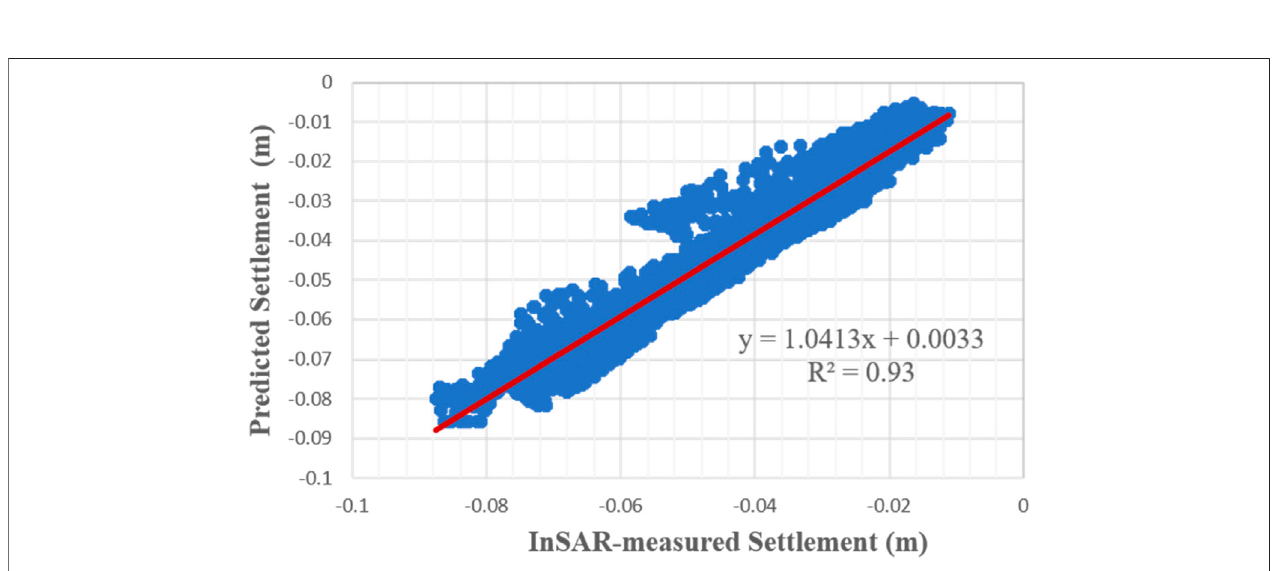
FIGURE 8 | Scatter plot between the InSAR-measured and the predicted cumulative settlement from 5 May 2019 to 14 May 2020. The red line is the fi tted linear trend between the both.